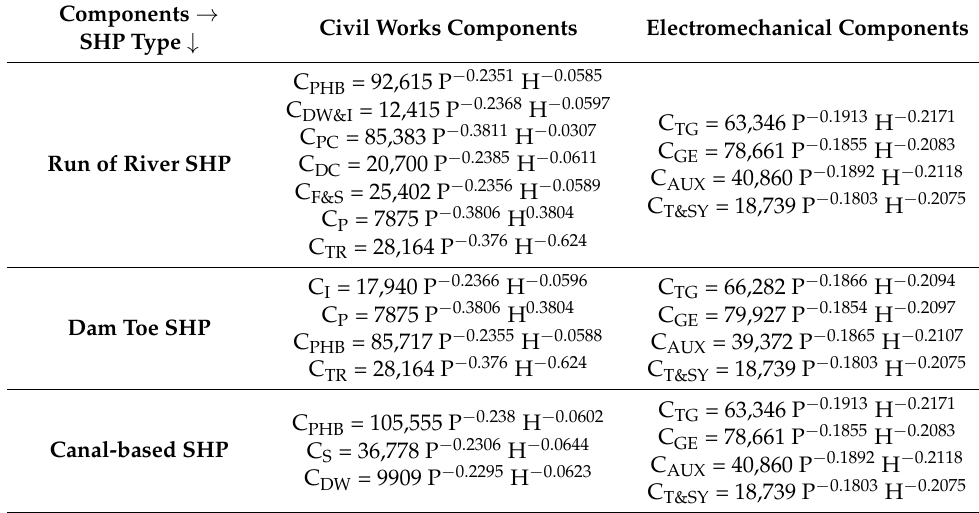
Table 3. Correlation for cost component of low-head